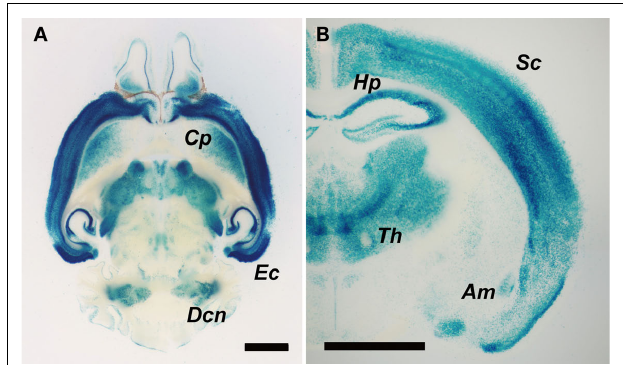
FIGURE 3 | LacZ expression in the brain of Cdkl2 LacZ/LacZ mice. (A) Horizontal (300-µm thick) and (B) coronal brain slices (100-µm thick) were prepared using a microslicer and stained with X-gal solution for 6 h at 37 ° C. Abbreviations: Cp , caudate-putamen; Ec , entorhinal cortex; Dcn ,